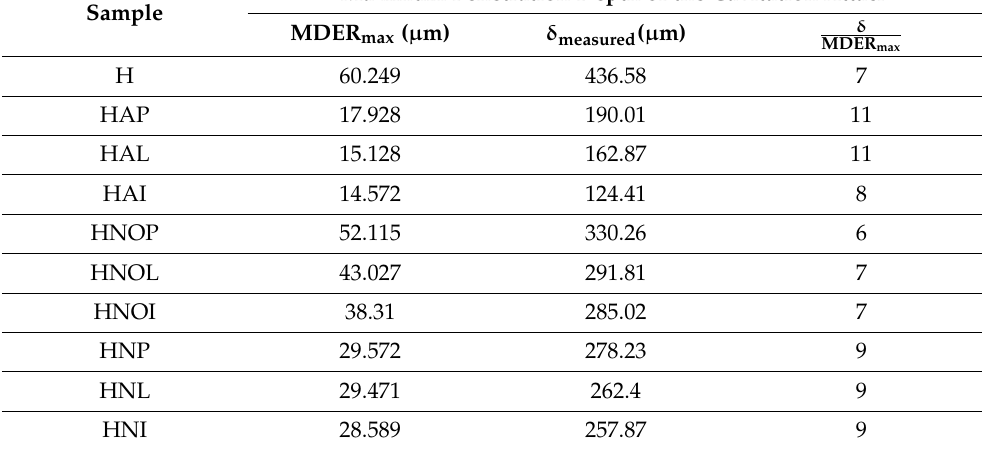
Table 6. Maximum depth of penetration of cavitation attack of 5083 aluminum alloy specimens in different heat treatment